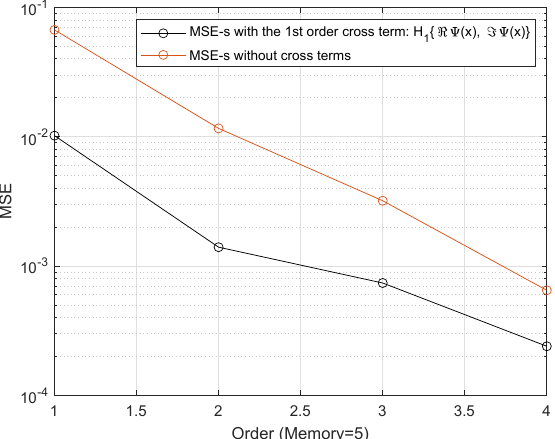
Figure 12. The mean squared error dependence on the kernel order with and without the first cross-term in the Volterra representation, when the memory is fixed to M = 5.